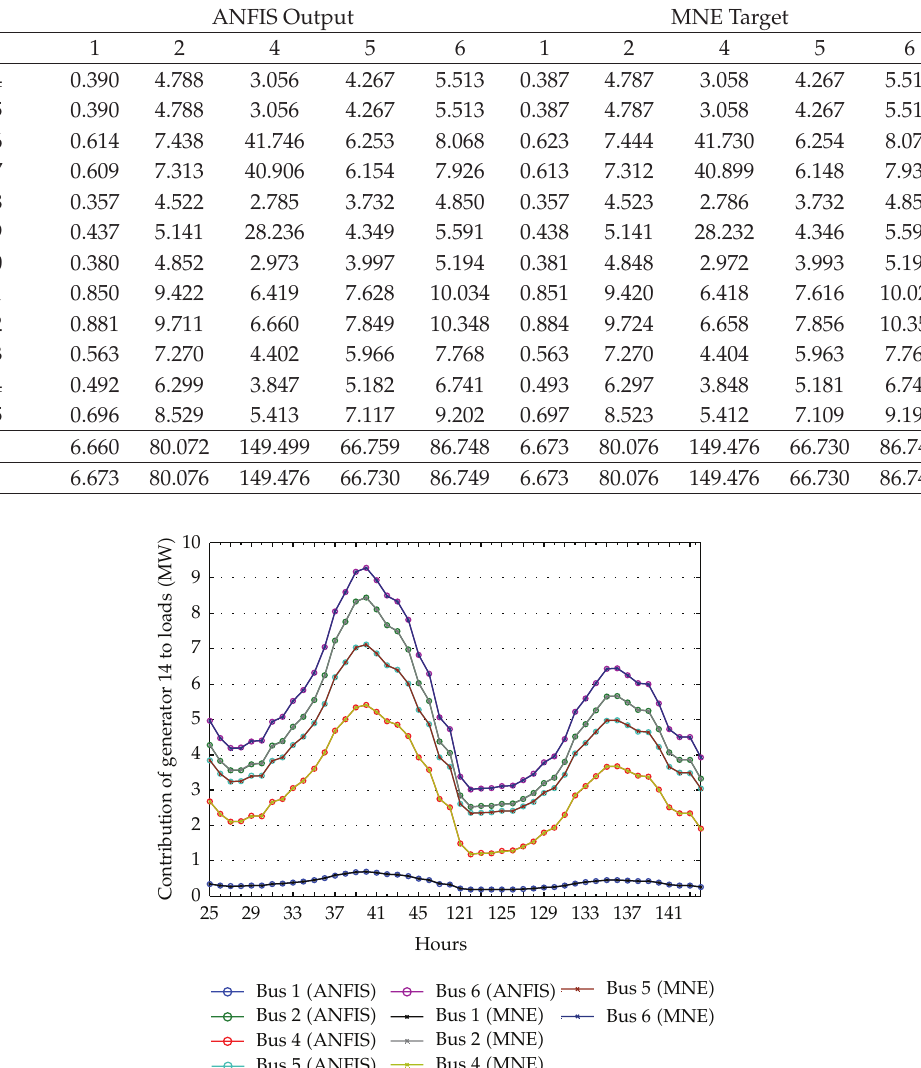
Figure 7: Distribution of real power from generator at bus 14 to loads within hours 25 to 48 and 121 and